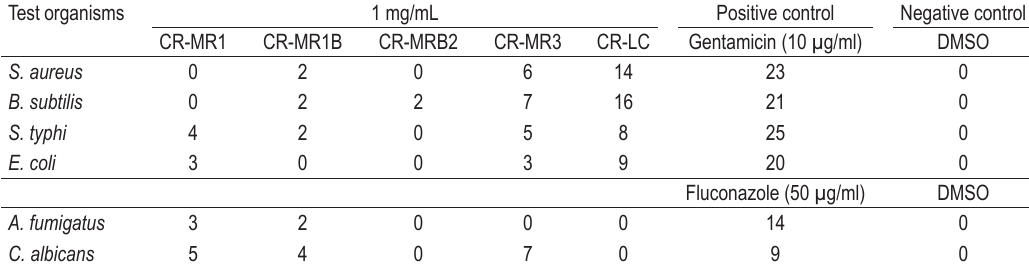
TABLE 1. Results of the antimicrobial evaluation of the fungal extracts showing the IZD (mm) produced against test organisms Test organisms